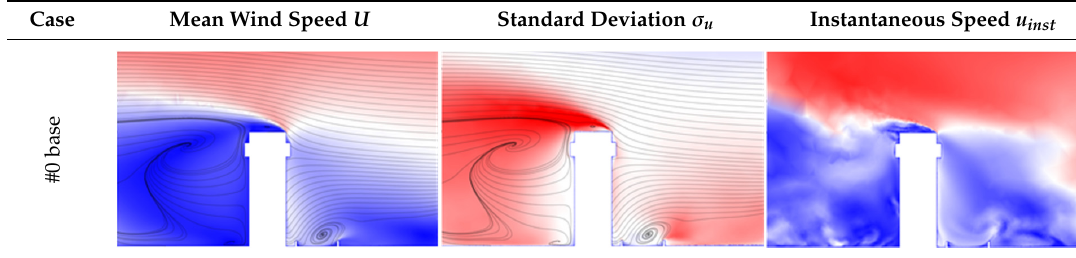
Figure 6. Turbulent Fluxes for the various computational domains compared with the experimental inflow. ( a ) uu , ( b ) vv , ( c ) ww and ( d ) uw normalized against the reference velocity U ref . Table 3. Flow pattern predicted by the di ff erent computational domains.